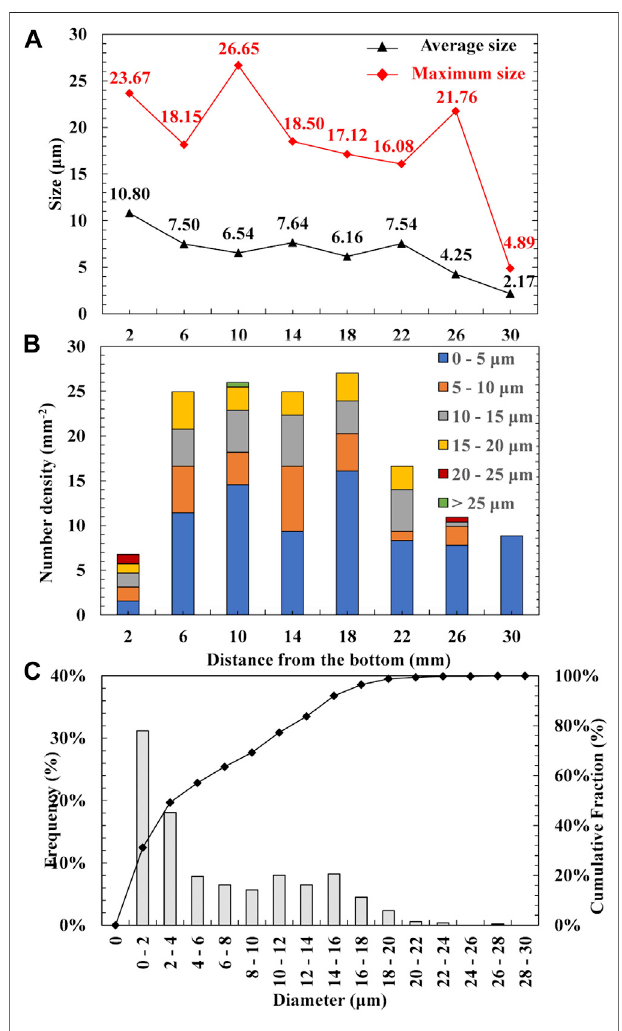
FIGURE 5 | Size (A) , number density (B) of AlN inclusions at different positions, diameter distribution of AlN inclusions in experimental sample (C) .